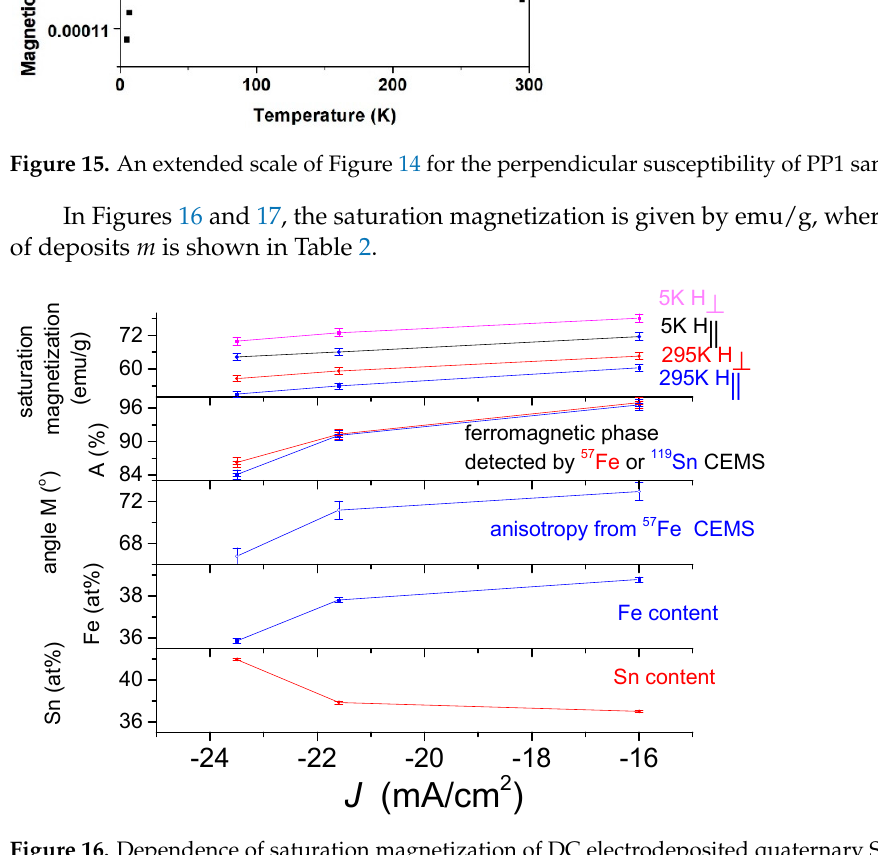
Figure 16. Dependence of saturation magnetization of DC electrodeposited quaternary Sn-Fe-Ni-Co alloy coatings on the current density, together with the current density dependences of the occur- rence of ferromagnetic phase detected by 57 Fe and 119 Sn CEMS, direction of average magnetization originated from 57 Fe CEMS, as well as Fe and Sn content.